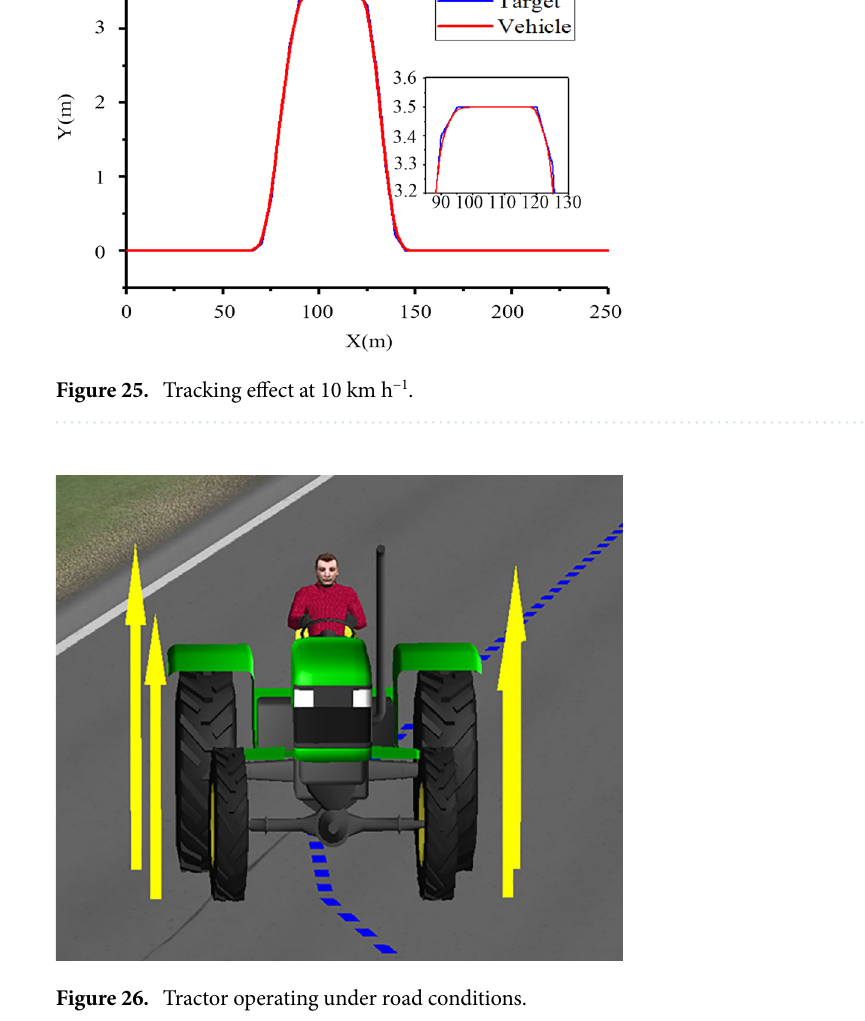
Figure 26. Tractor operating under road